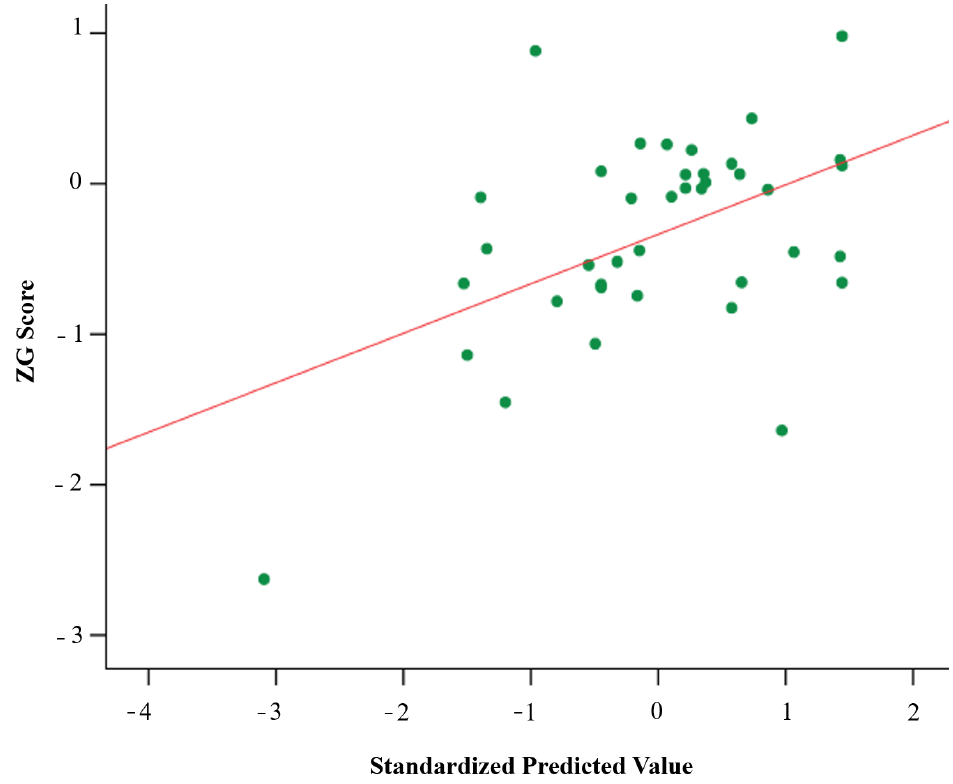
Figure 2. Associations between standardized predicted values and observed global neuropsychological scores. Scatterplot with a trend line depicting the correlations between global cognitive (ZG) scores predicted from multiple regression analyses, with ZG scores observed as the dependent variable and MIDAS ( β = –0.348) and VAS (attack) scores ( β = 0.409) as the independent variables.